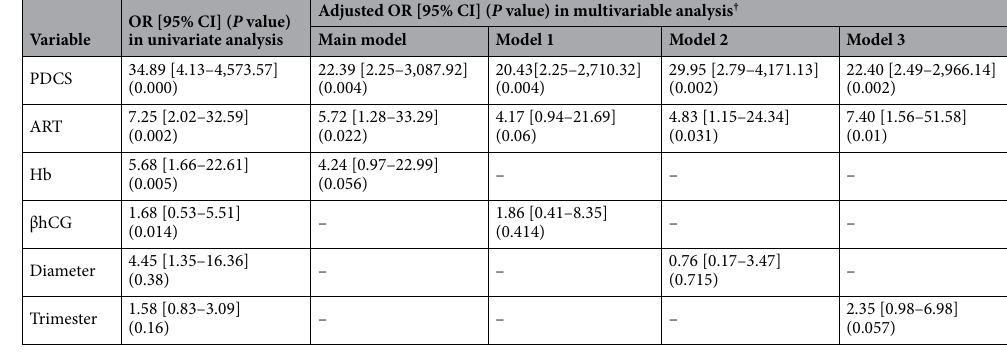
Table 2. Odds ratio of variables for massive hemorrhage in univariable and multivariable logistic regression models. Multivariable analysis was evaluated in four models. OR, odds ratio; CI, confidence interval; PDCS, power Doppler color scoring; ART, assisted reproductive technology; Hb, serum hemoglobin; βhCG, serum β-human chorionic gonadotropin. † Logistic regression model with Firth’s correction method. P value of < 0.05 were considered statistically significant.